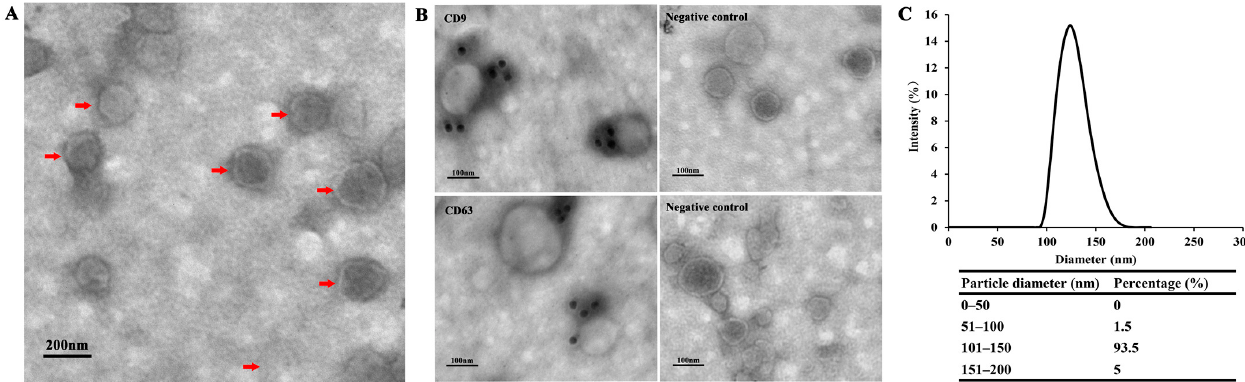
Figure 1. Characterization of exosome-like vesicles isolated from the culture medium of T. pisiformis cysticercus. ( A ) Morphological characterization of T. pisiformis cysticercus exosome-like vesicles by TEM. The red arrowheads indicate the exosome-like vesicles negatively stained with phosphotungstic acid. ( B ) Immunoelectron microscopy analysis of CD9 and CD63 proteins in the purified exosome-like vesicles. ( C ) Size distribution of exosome-like vesicles of T. pisiformis cysticercus by